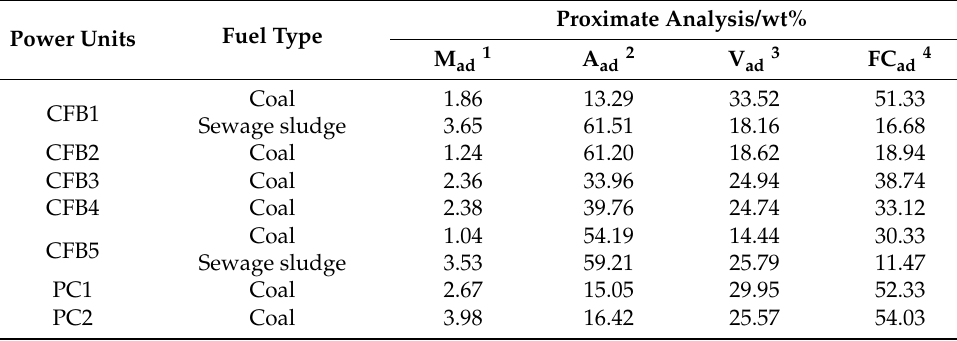
Table 2. Proximate analysis of feed fuel samples from coal-fired power units. Power